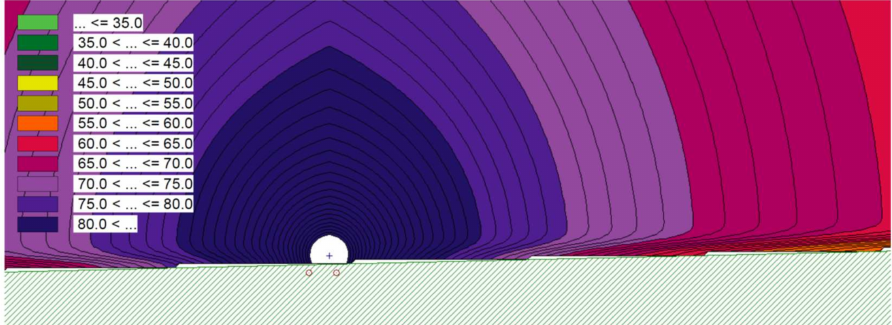
Figure 10. Simulation of sound propagation from the source without a barrier.